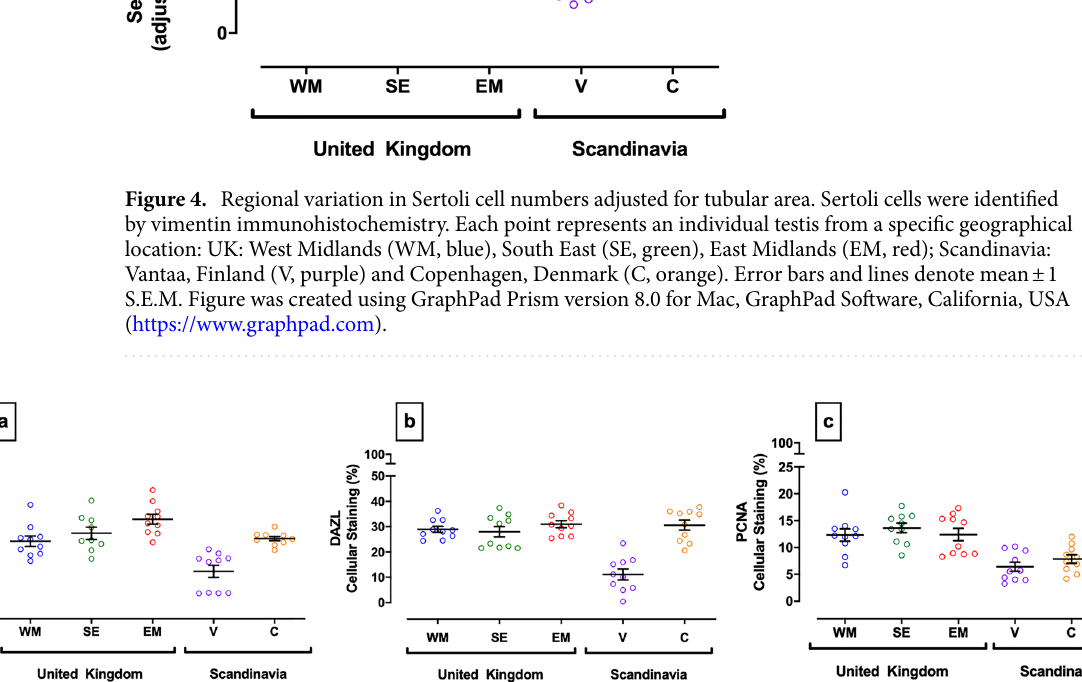
Figure 5. Quantification of immunostaining for vimentin (Sertoli cells), DAZL (germ cells) and a marker of cellular proliferation (PCNA) in dog testes from different geographical locations. ( a ) Vimentin, ( b ) DAZL, ( c ) PCNA. Each point represents an individual testis from a specific geographical region: UK; West Midlands (WM: blue), South East (SE: green) East Midlands (EM: red) and Scandinavia; Vantaa, Finland (V: purple) and Copenhagen, Denmark (C: orange). Error bars and lines denote mean ± 1 S.E.M. Figures were created using GraphPad Prism version 8.0 for Mac, GraphPad Software, California, USA (https:// www. graph pad. com).